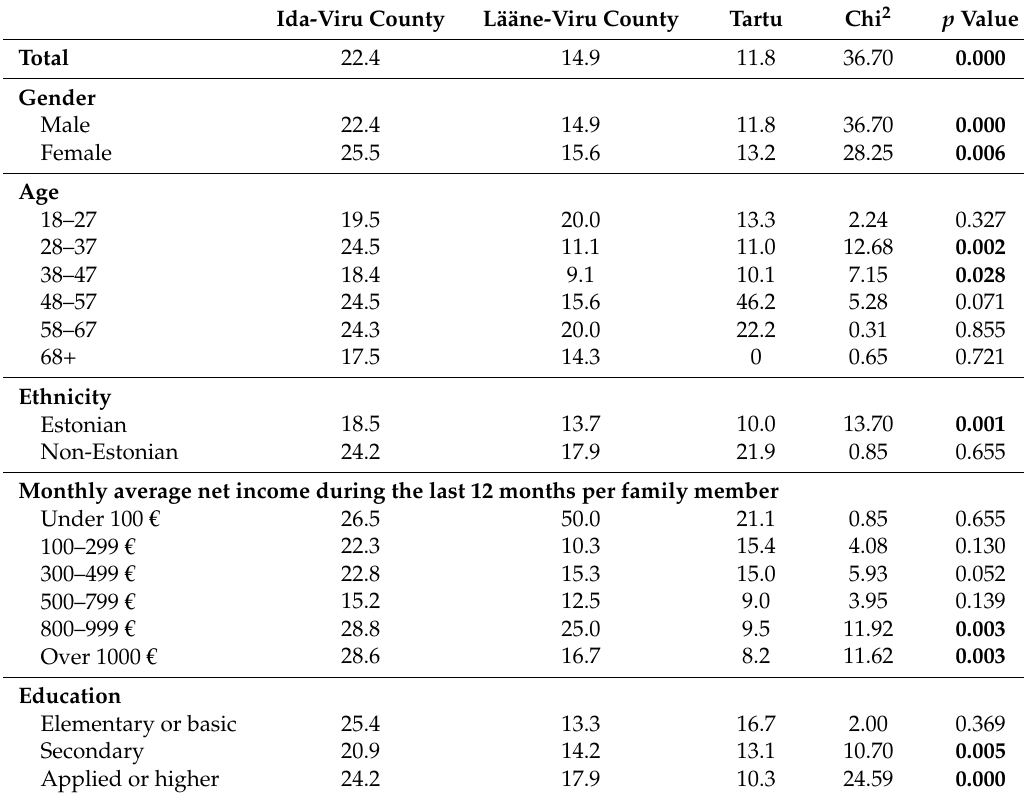
Table A2. High annoyance (%) due to air pollution * per demographics and health problems of people in Ida-Viru County and the control regions (Lääne-Viru and Tartu), and regional